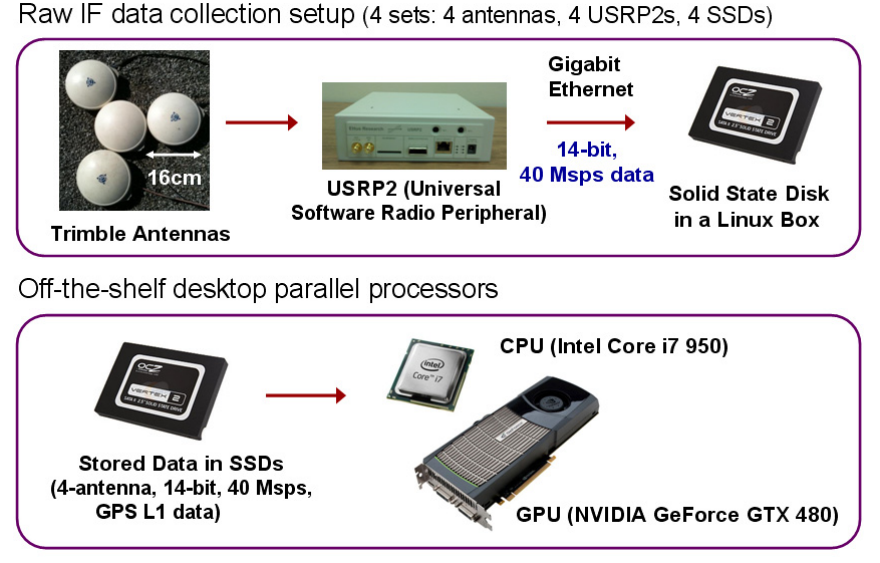
Figure 4. Hardware setup for GPS SDR for four-element CRPA